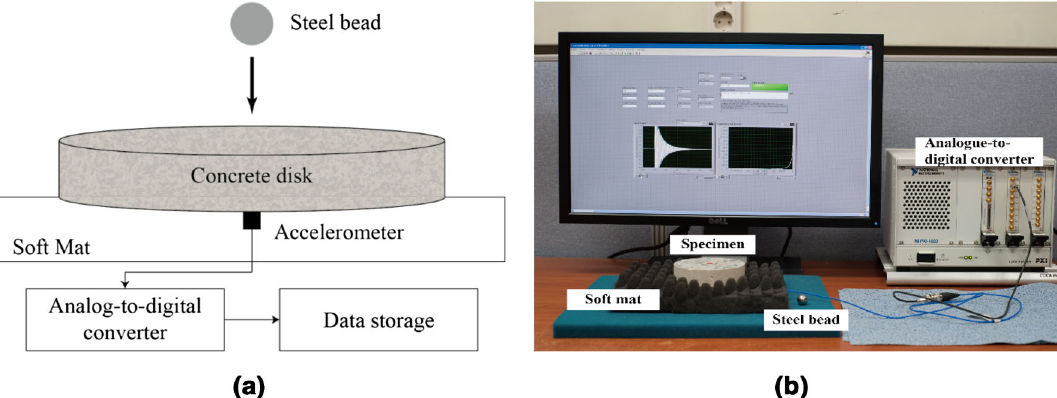
Fig. 1 Experimental setup of nonlinear resonance vibration method. a Schematic of experimental system and b experimental setup.